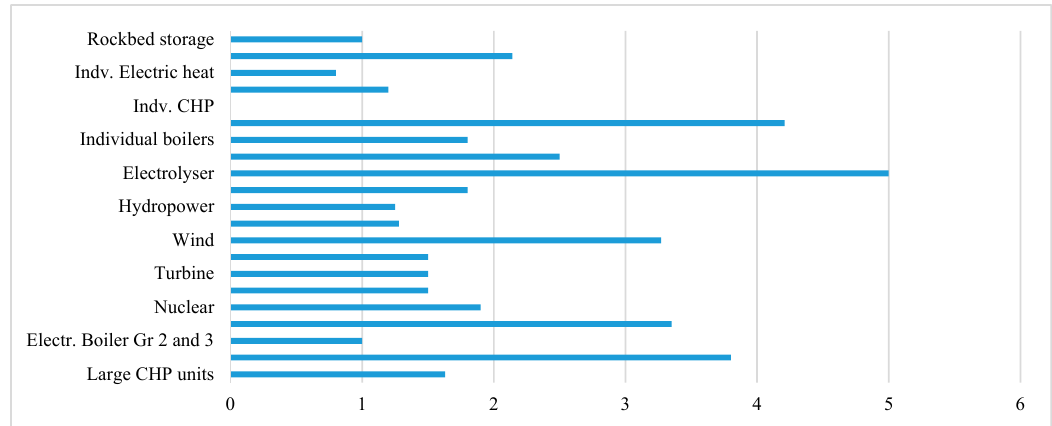
Figure 5. Production unit investment costs and lifetime. Energies 2019 , 12 , x FOR PEER REVIEW